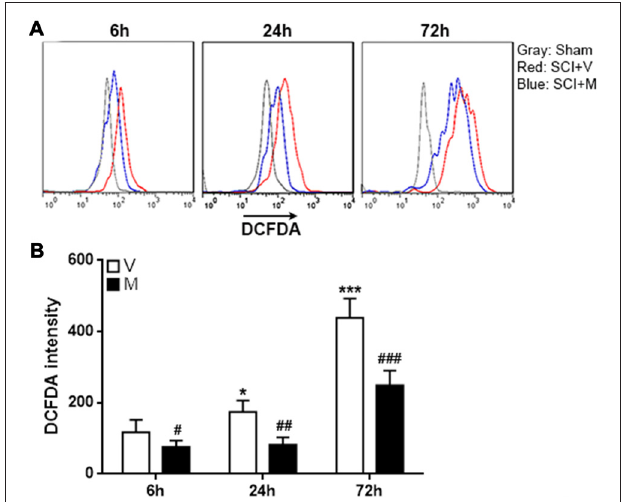
FIGURE 5 | Methylene blue diminished reactive oxygen species (ROS) production in post-SCI microglia. (A) Representative histograms indicating the H2DCFDA staining. (B) Statistical analysis for the H2DCFDA intensity. V: vehicle; M: methylene blue treatment. ∗ p < 0.05; ∗∗∗ p < 0.001 in comparison with the “6 h” vehicle group. # p < 0.05; ## p < 0.01; ### p < 0.001 in comparison with the corresponding vehicle group at each time point. N = 5 per